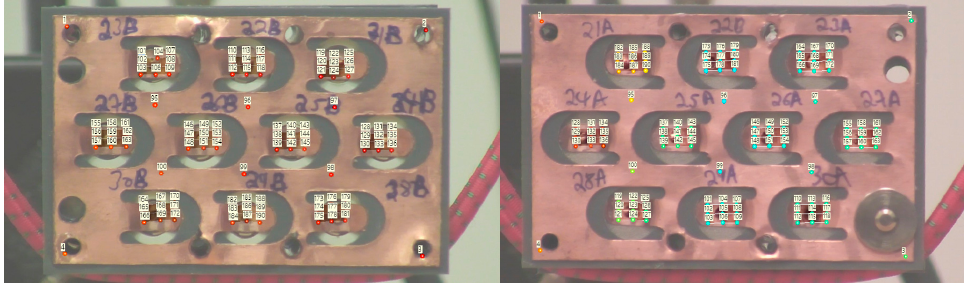
Figure 10. Observation locations on the 110 A supercell. ( Left ): from the side of the busbar with positive cell terminals. ( Right ): from the side of the busbar with negative cell terminals.